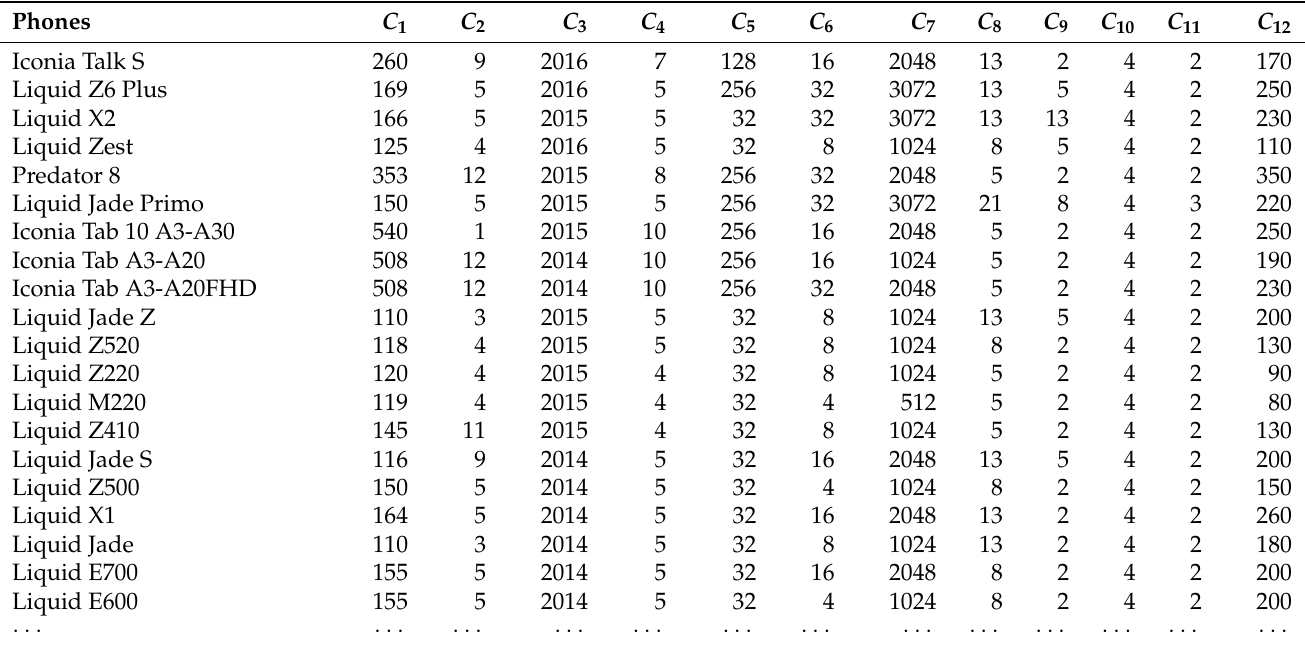
Table 13. Decision matrix for the whole set of alternatives.